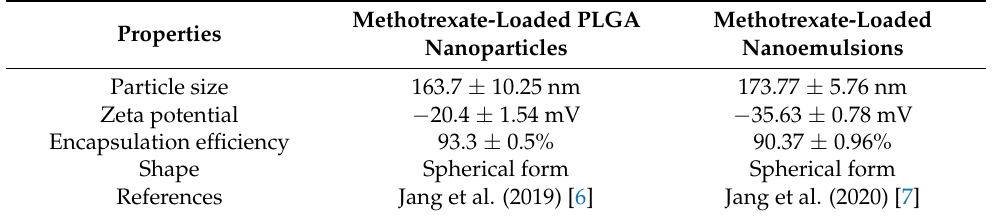
Table 5. Comparison of the basic physicochemical properties of different methotrexate- loaded